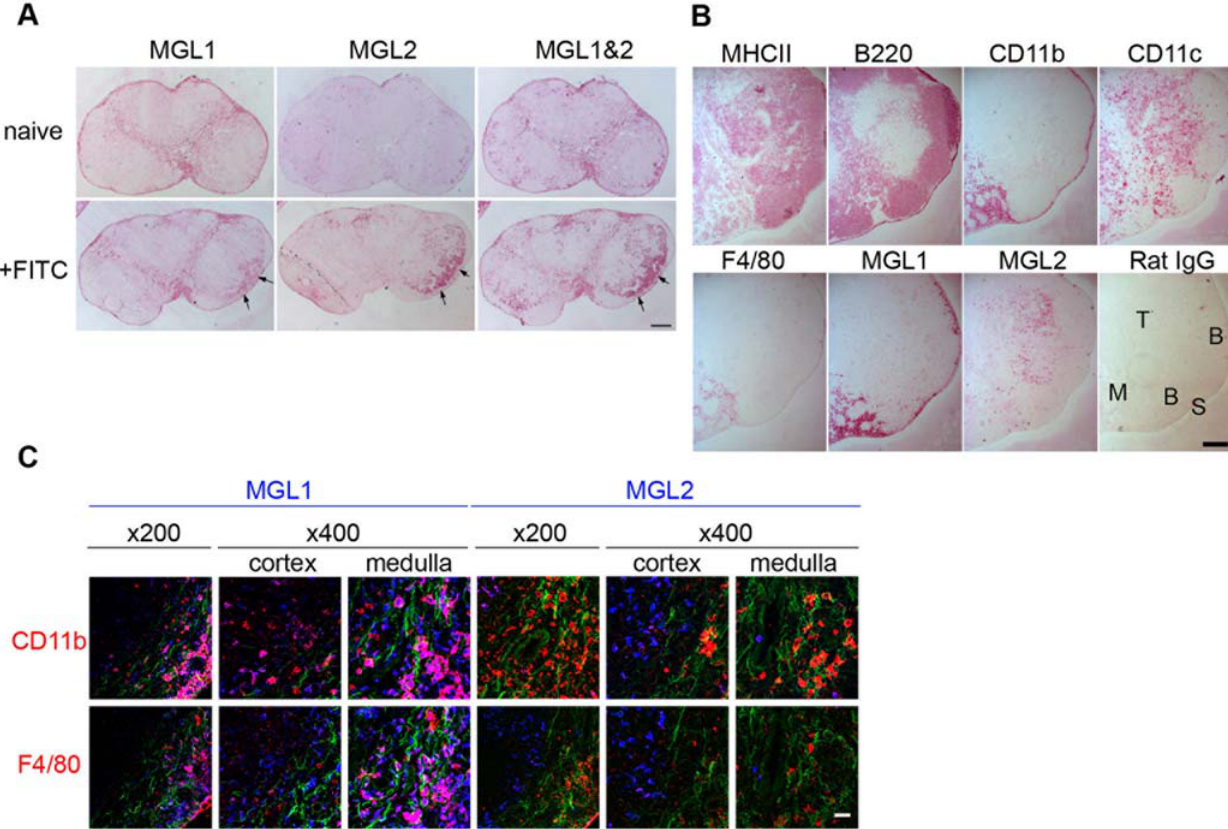
Figure 2. Distribution of MGL2 + cells in draining LNs during the sensitization with FITC revealed by immunohistochemical analysis. (A) Serial sections of LNs stained with anti-MGL1, anti-MGL2 or anti-MGL1/2 cross-reactiv mAbs. MGL1 was strongly stained in the sinuses in both naive and FITC sensitized (24 h after sensitization) LNs. Arrows indicate the increased signals in the cortex after the sensitization, though the anti- MGL1 staining in the cortex was weaker than in the sinuses. Scale bar, 250 m m. (B) Serial LN sections 4 h after sensitization stained with mAbs to MØ/ DC markers. Restricted localization of MGL2 + cells to the outer T cell cortex was unique compared to other APCs (MHCII) including B cells (B220), MØs (CD11b and F4/80), DCs (CD11c) or MGL1 + cells. S: subcapsular sinus, M: medulla, T: T cell cortex, B: B cell follicle. Scale bar, 200 m m. (C) Confocal microscopic observations of the distributions of MGL1 (mAb LOM-8,7) or MGL2 (mAb URA-1) (blue in each panel) with MØ markers (red) in the LN 24 h after FITC sensitization. FITC used is shown in green. Scale bar, 25 m m ( 6